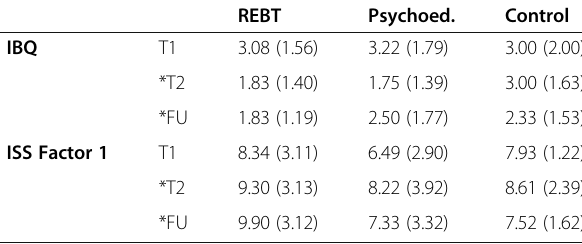
Behavioral Therapy. * p <0.05 compared to